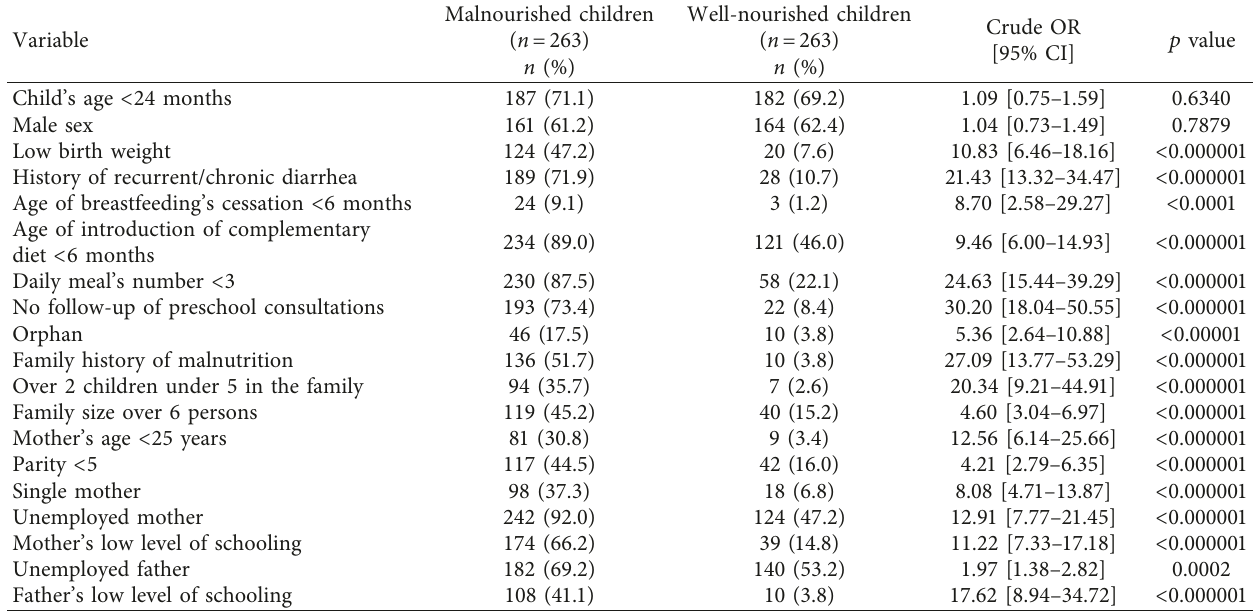
Table 1: Bivariate analysis of risk factors for malnutrition among children aged 6–59 months in Lubumbashi (DRC).